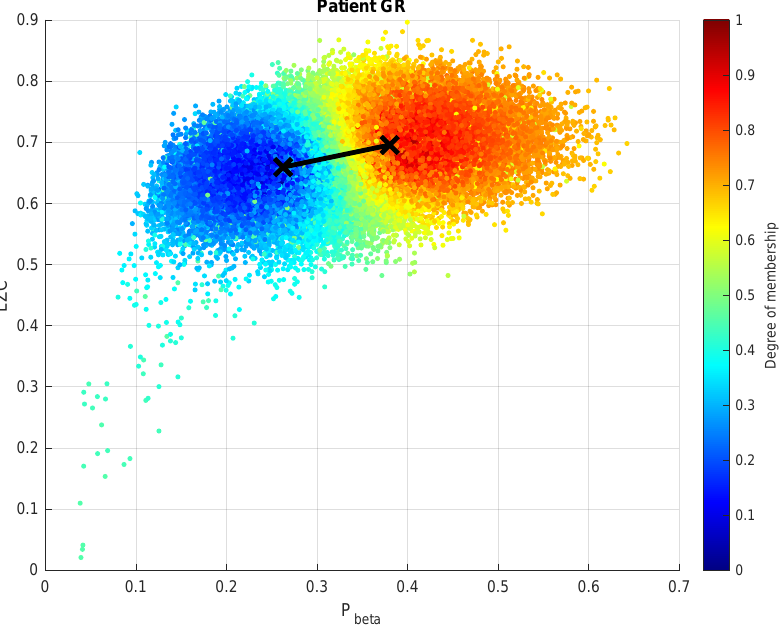
Figure 8. FCM clustering of P beta and LZC, the two features with the highest correlation coefficients to the final result. The majority of LZC values are representative of a higher level of consciousness (largely above 0.5). Ideally, data points representing unconscious states are located in the bottom left corner of the plot, while those describing conscious states are located in the top right corner.